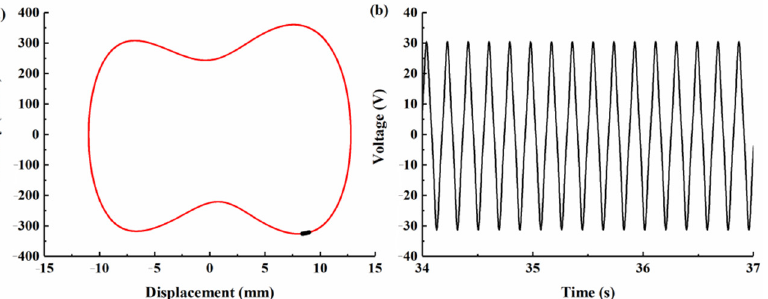
Figure 10. Simulation results for BPEH-V under excitation frequency f = 5 Hz. ( a ) Phase plane portrait and Poincaré map. ( b ) Output voltage histories.